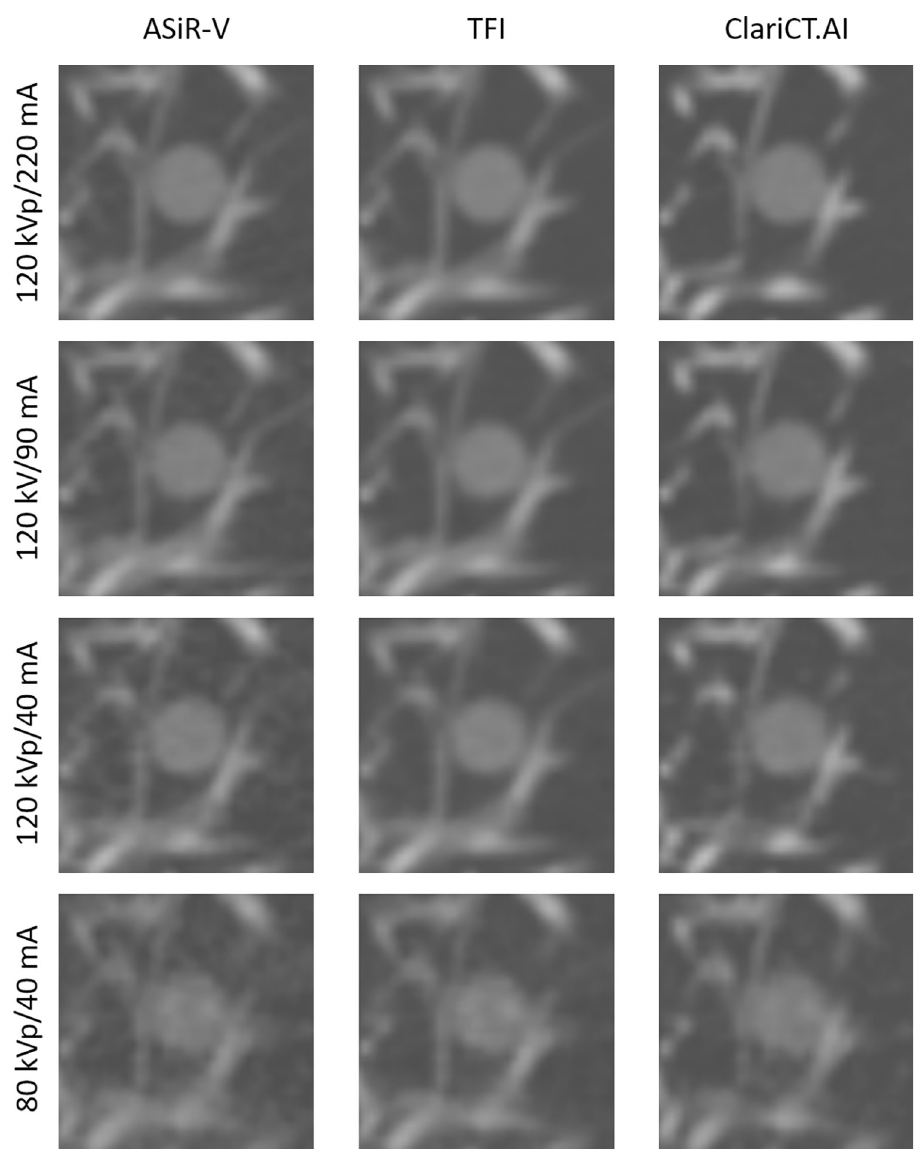
Fig 2. CT images of GGNs at different radiation dose settings. Images of GGNs (8 mm) with an attenuation of − 630 HU at four radiation dose settings reconstructed with ASiR-V, TFI, and ClariCT.AI.